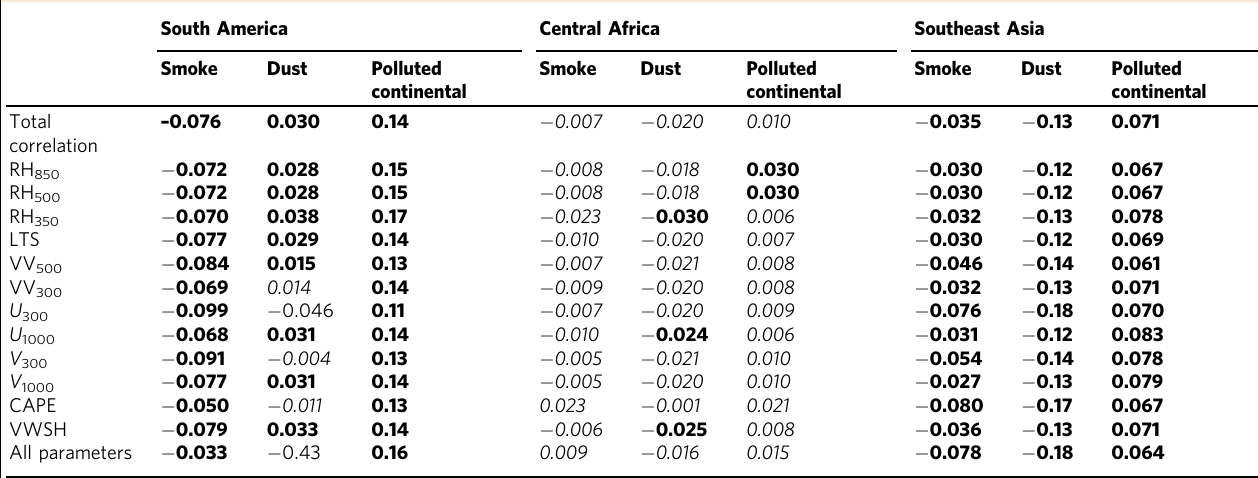
Table 1 Total correlations between column AOT and IWC centroid, and the partial correlations with the effects of 12 meteorological parameters eliminated individually and simultaneously over all seasons South